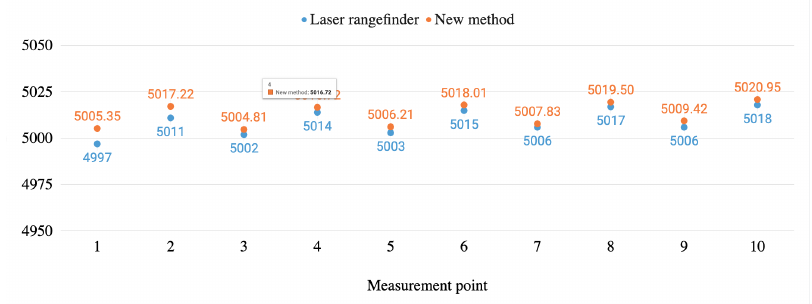
Figure 12. Height measurements’ comparison between the new method and the laser rangefinder in the test bench environment.